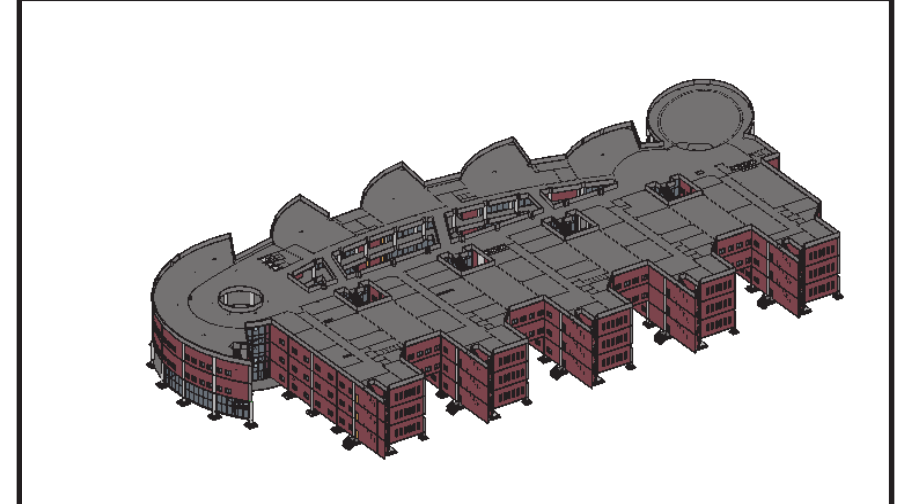
Fig. 3. BIM model of the case